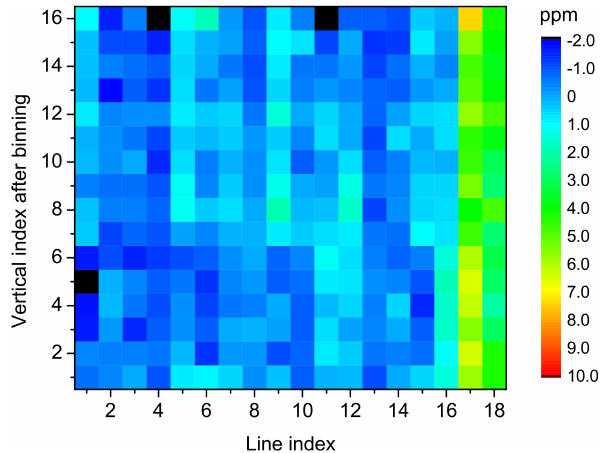
Figure 19. Relative line position error in ppm for selected spectral lines across the detector array, calculated for super-pixels consisting of 48 × 8 pixels. The line indices 1 to 16 correspond to the ones given in Table 1, the line indices 17 and 18 correspond to the two H 2 O lines given in the text.